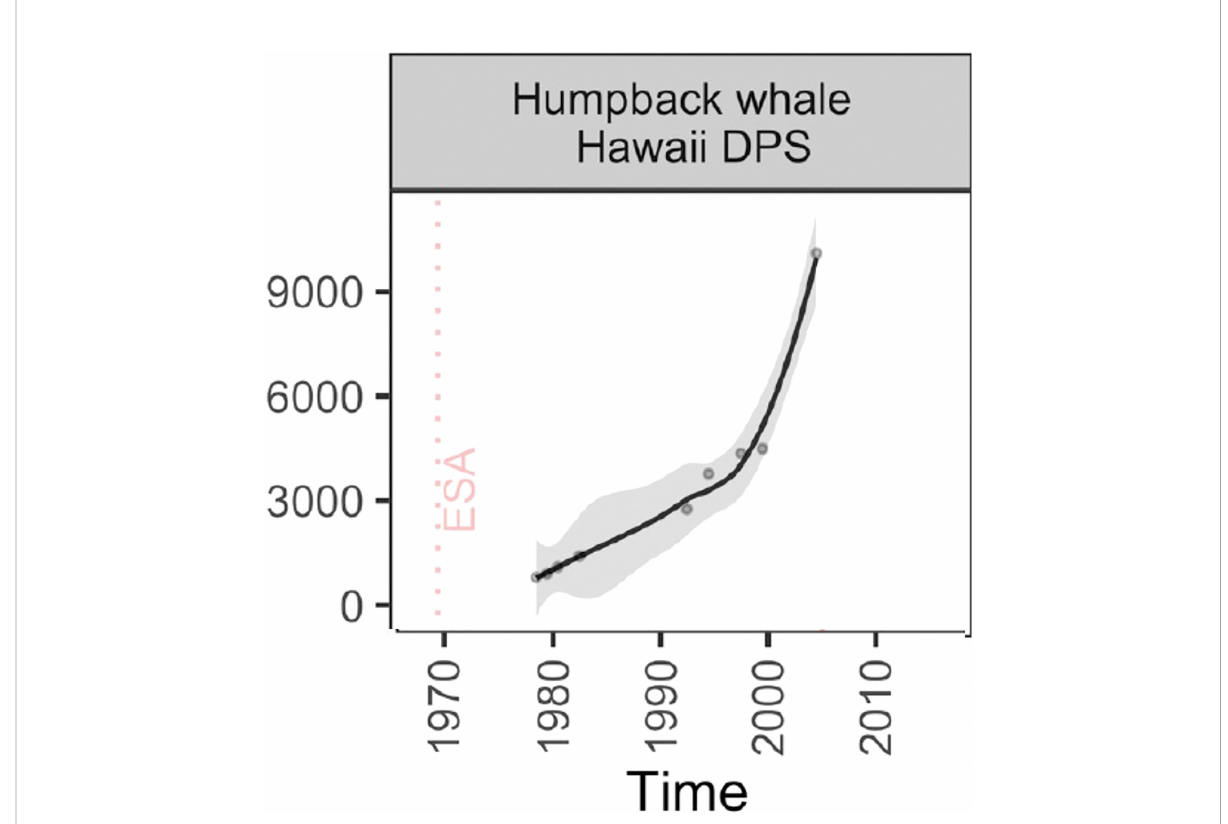
FIGURE 10 Population level trend on Humpback whale Hawaii DPS. Source: Valdivia et al.